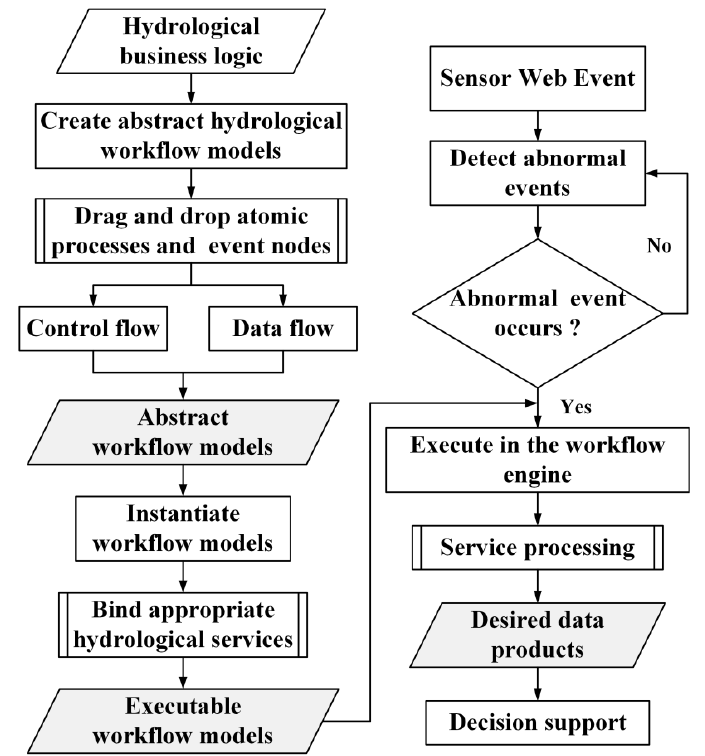
Figure 5. Flowchart diagram illustrating the process of workflow-based hydrological service chaining.